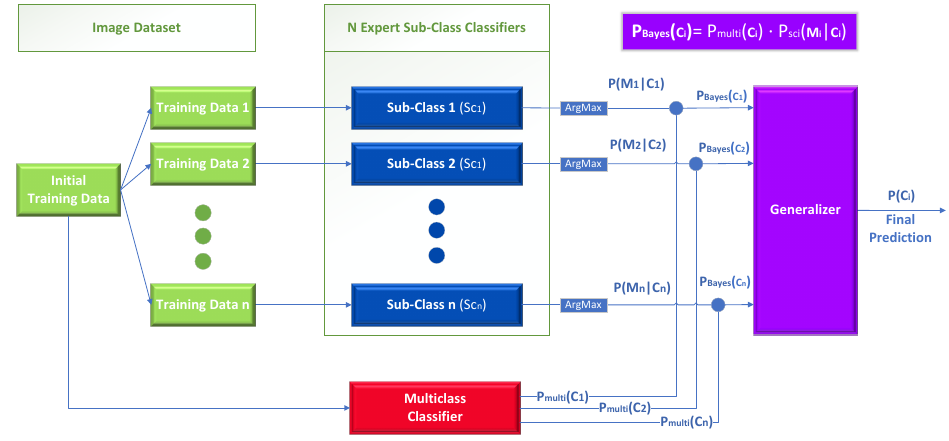
Figure 3. The architecture of the Bayes-theorem-based Ensemble